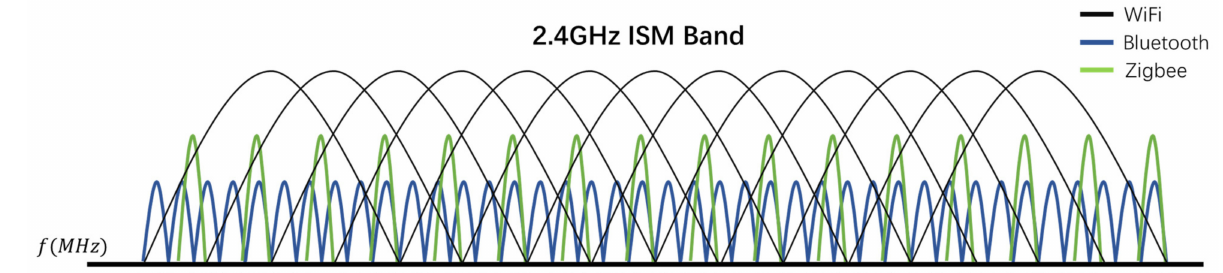
Figure 7. Bluetooth, WiFi, and ZigBee signal distribution in 2.4 GHz ISM frequency band.